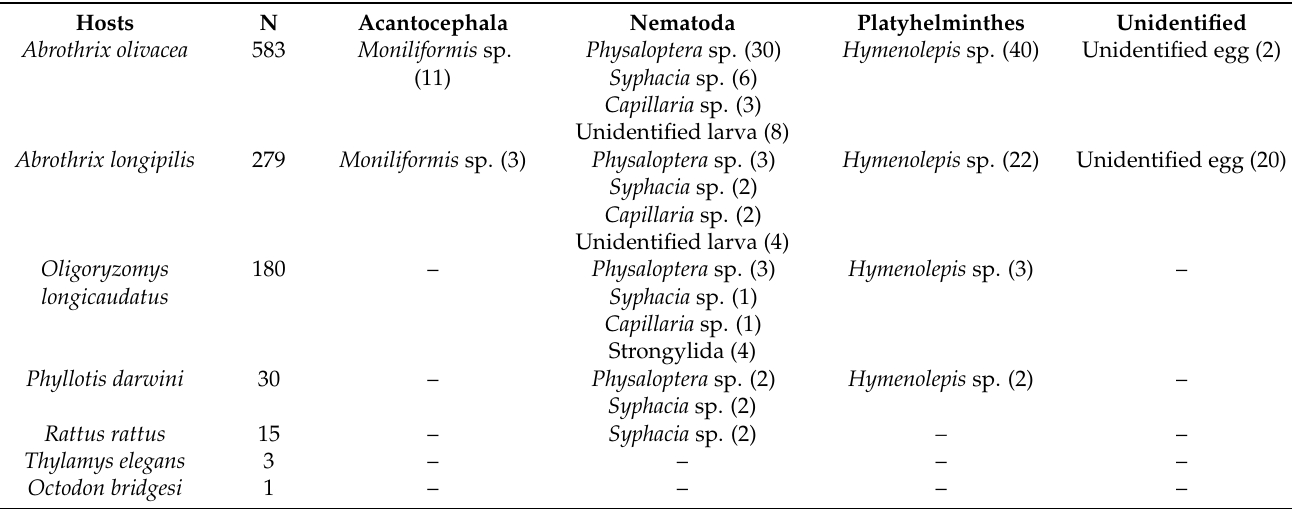
Table 1. Presence of helminth eggs and larvae from fecal samples of small mammals. N = sample size. Number in parentheses is the number of positive samples.